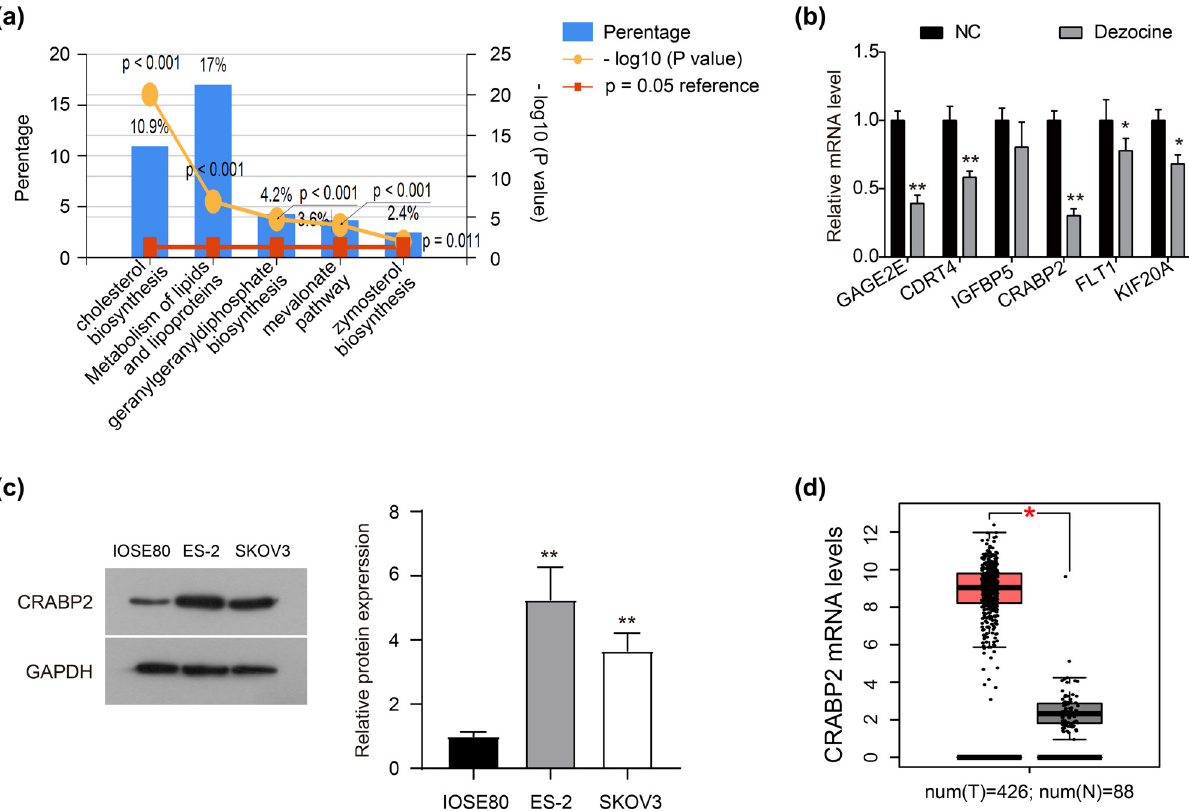
Figure A1: Dezocine regulates multiple genes expression in ES - 2 cells. ( a ) Classi fi cation and statistics of GO biological pathways of the di ff erentially expressed genes in dezocine - treated cells using FunRich 3.1 software. ( b ) Expression of possible downstream e ff ector genes ( GAGE2E, CDRT4, IGFBP5, CRABP2, FLT1, and KIF20A ) for dezocine in ES - 2 cells. ( c ) The protein expression of CRABP2 in IOSE80 ( Human normal ovarian epithelial cell line ) , ES - 2 and SKOV3 cells. ( d ) The CRABP2 mRNA levels in ovarian cancer tissues ( Red column, n = 426 ) and normal ovarian tissues ( Grey column, n = 88 ) . Data from GEPIA. * P < 0.05, ** P <